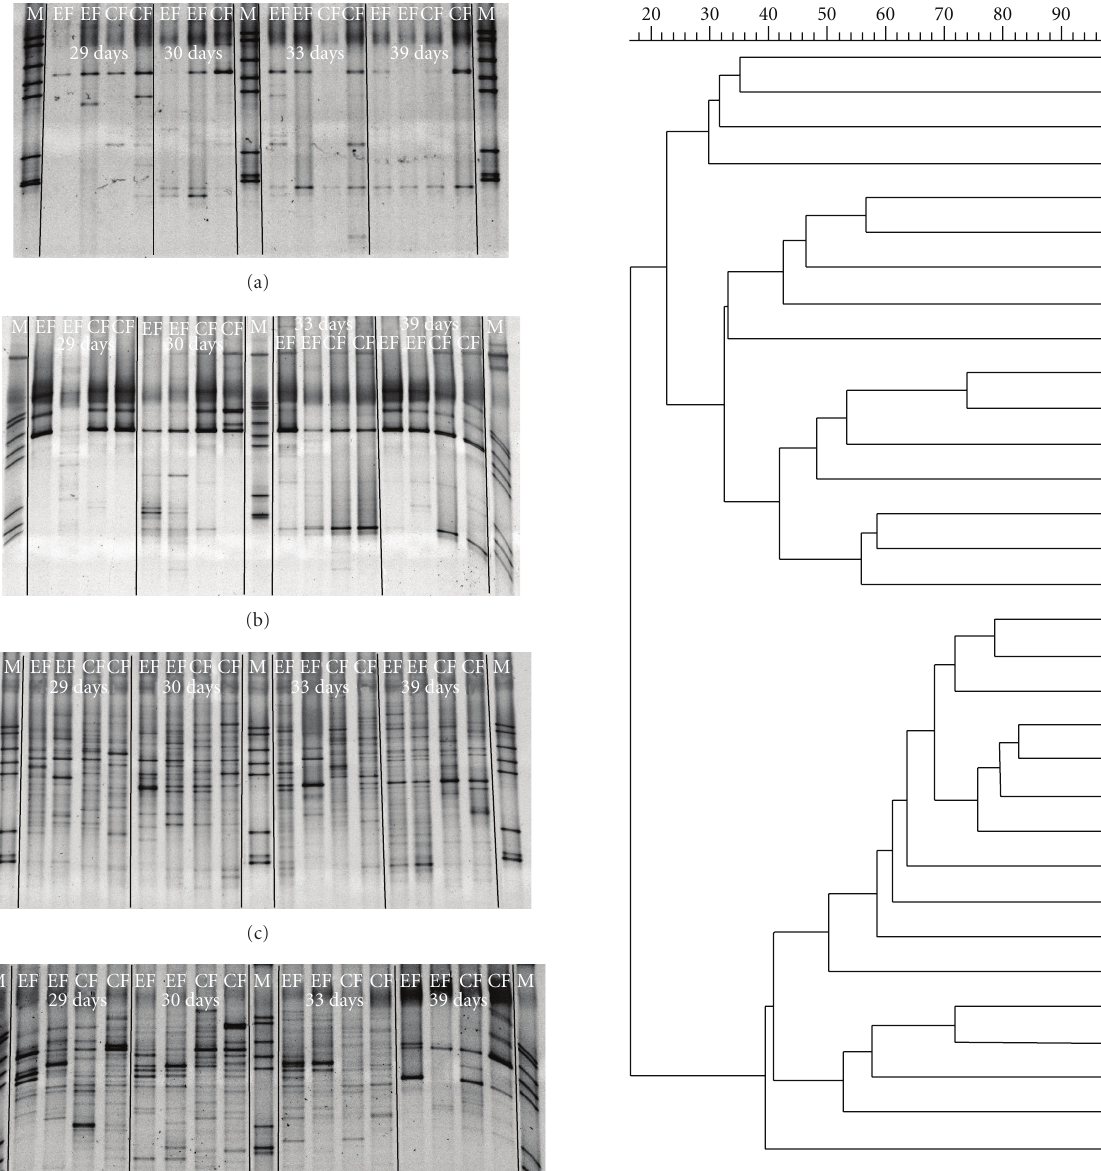
Figure 5: Cluster of denaturing gradient gel electrophoresis finger- prints of amplicons of bacterial V6–V8 fragments of 16S rRNA gene obtained from colon digesta of piglets fed after weaning starter diet with 0 . 04% of essential oils mixture containing limonene, pinene, and eugenol. Similarity was calculated using Pearson coe ffi cient, and the cluster was formed by means of unweighted pair group method with averaging. EF—experimental farm, CR—commercial farm, 29, 30, 33, 39—age of piglets (d) corresponding to 1, 2, 5, and 11 days after weaning, respectively. Upper bar shows the distance of similarity in